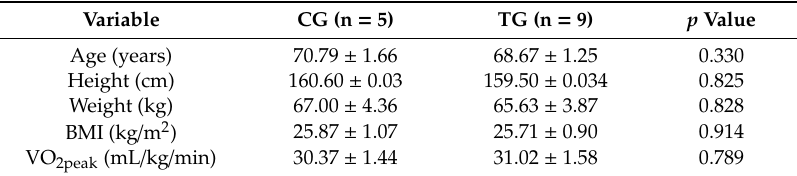
Table 1. Participant anthropometric